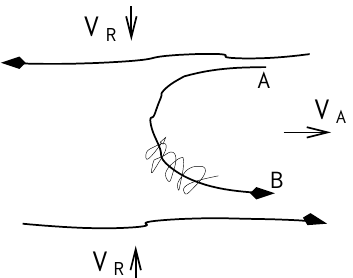
Fig. 5. The simplest realization of magnetic reconnection at small scale and of acceleration as an energetic particle bounces back and forth between converging magnetic field lines. The converging ve- locity determines the reconnection speed V R , while the advection of the accelerated particles entrained on the magnetic field lines, occurs at an outflow speed that in most cases is of order the Alfv´en velocity of the plasma V A . Particles bouncing at points A and B happens because either of streaming instability induced by ener- getic particles or magnetic turbulence in the reconnection region. In an actual turbulent plasma, the outflow region, at large scale, is filled with reconnecting loops and current sheets, each of which a possible acceleration site (see text). From Lazarian (2005).